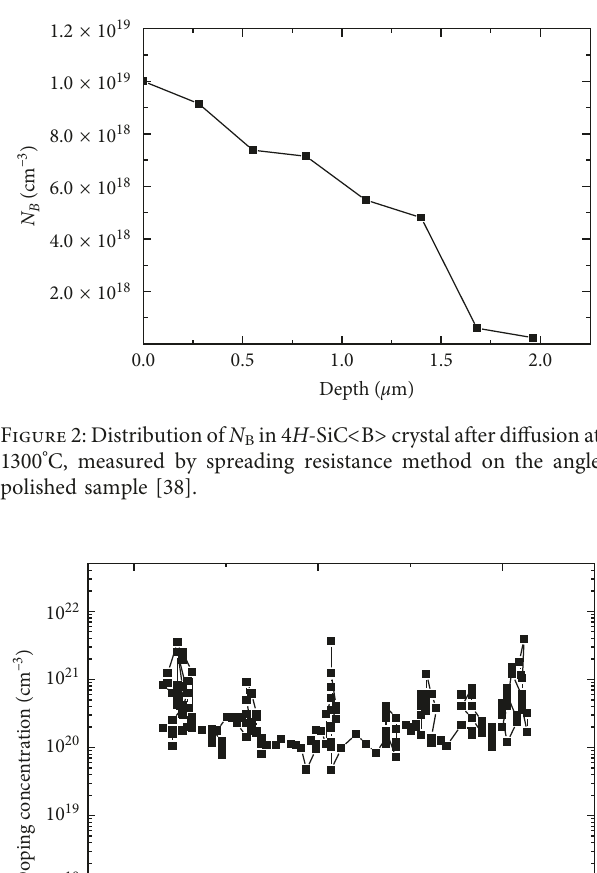
Figure 3: Distribution of boron on the top of p -region of 3 C - SiC B (measured using Ni- p -SiC Schottky barriers) < >